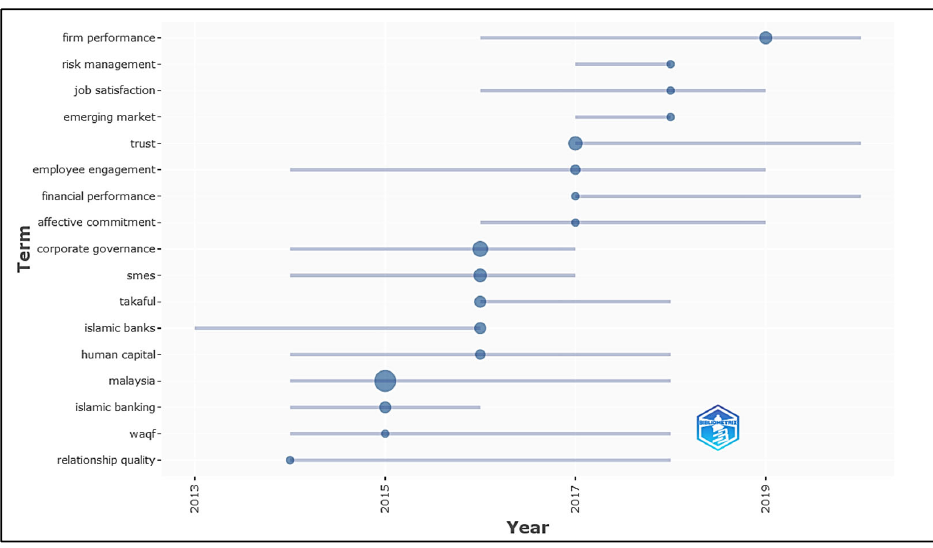
Figure 6. Trend topics of Jurnal Pengurusan.